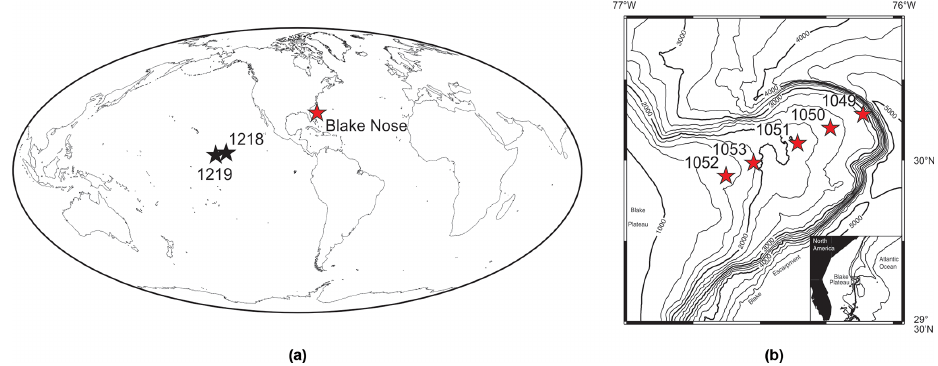
Figure 1. Maps showing the location of sites considered in the present paper: (a) Blake Nose (red star) in the western North Atlantic and eastern equatorial Pacific sites (black stars). Base map generated using Ocean Drilling Stratigraphic Network (2021) Advanced Plate Tectonic Reconstruction service (https://www.odsn.de/, last access: 12 April 2021). (b) Location of the Ocean Drilling Program (ODP) Leg 171B sites on Blake Nose. Modified from Shipboard Scientific Party (1998a). Table 1. Sites included in this study, along with geographic coordinates, site chapters, and number of samples examined for bio SiO 2 . Sites used for bio SiO 2 flux calculations are in